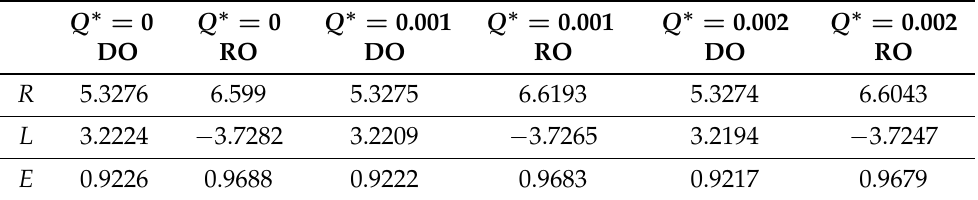
Table 5. Similar to Table 4, but the parameters are a = 0.2 and B ∗ = 0.01. Q ∗ = 0